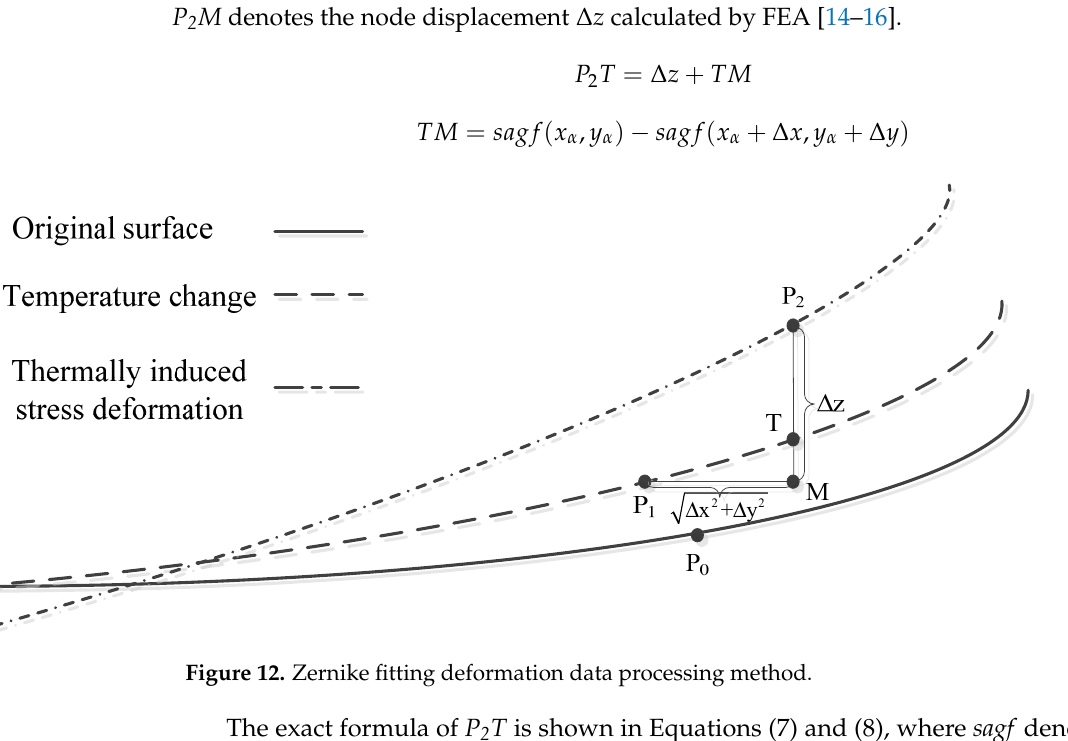
Table 6. Glass selection and error functions of conventional athermalization results.